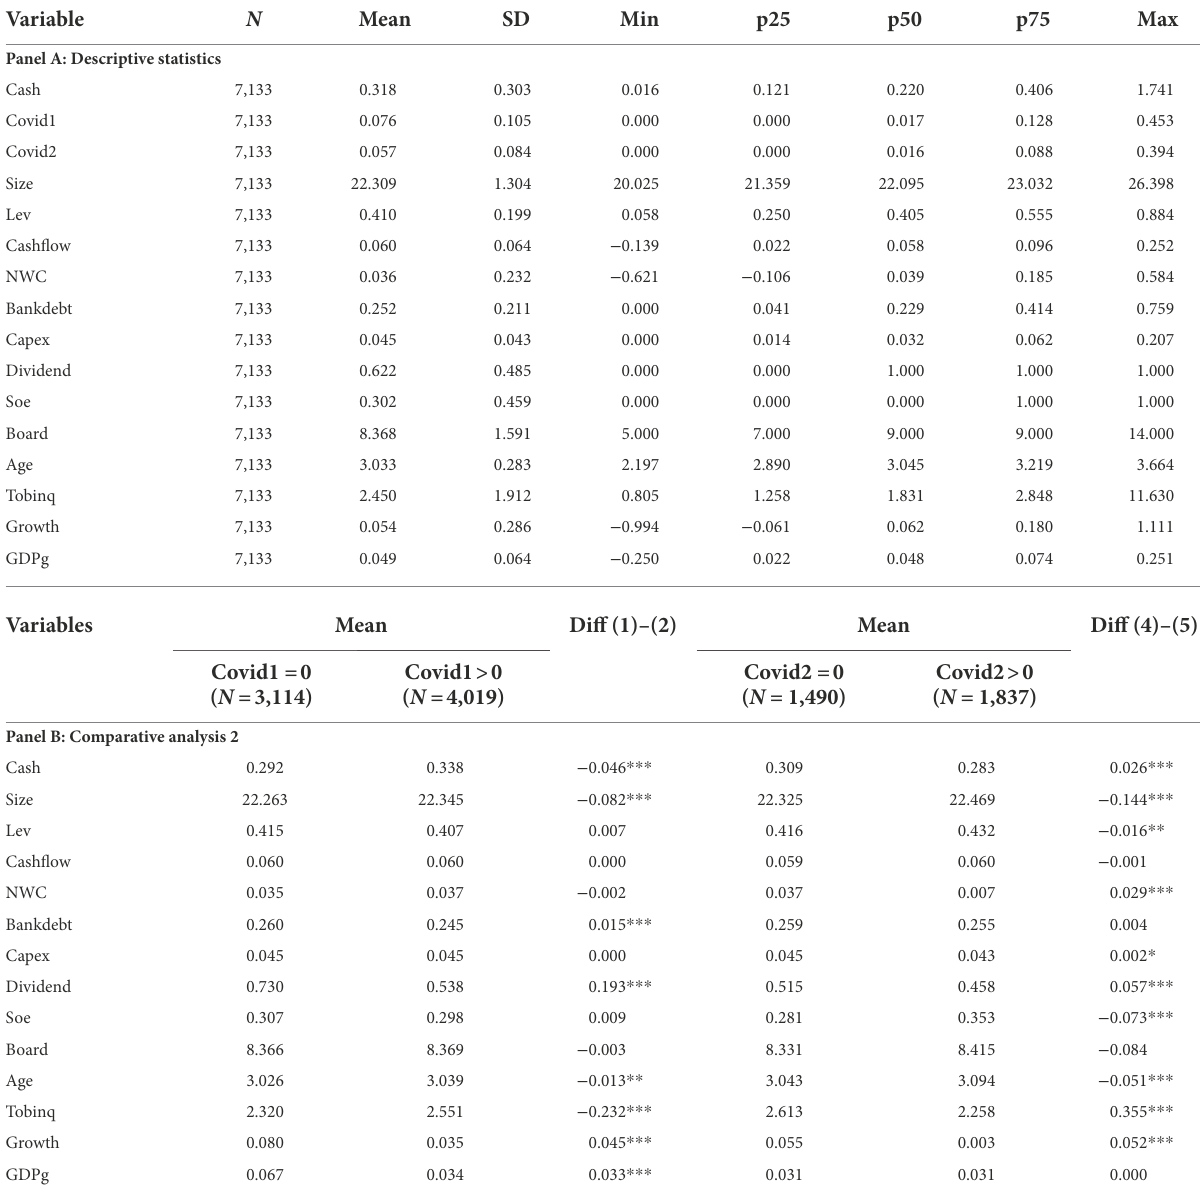
TABLE 1 Descriptive statistics of each variable and its mean difference.